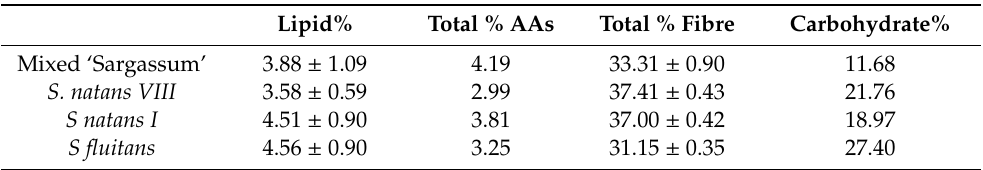
Table 9. Lipid ( n = 3), total fibre ( n = 3), total amino acid ( n = 1) and digestible carbohydrate expressed as a percentage of dry